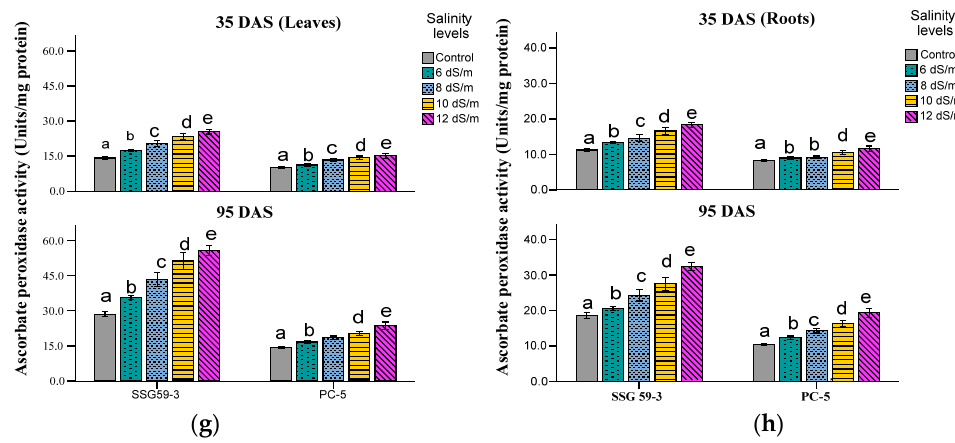
Figure 6. Effect of salt stress on superoxide dismutase (SOD, ( a , b )), catalase (CAT, ( c , d )), peroxidase (POX, ( e , f )), and ascorbate peroxidase (APX, ( g , h )) of sorghum genotypes at 35 and 95 DAS. Post hoc comparisons of the means were performed using Tukey’s HSD test at p < 0.05; different letters ( a–e ) indicate significant differences among treatments within each genotype.